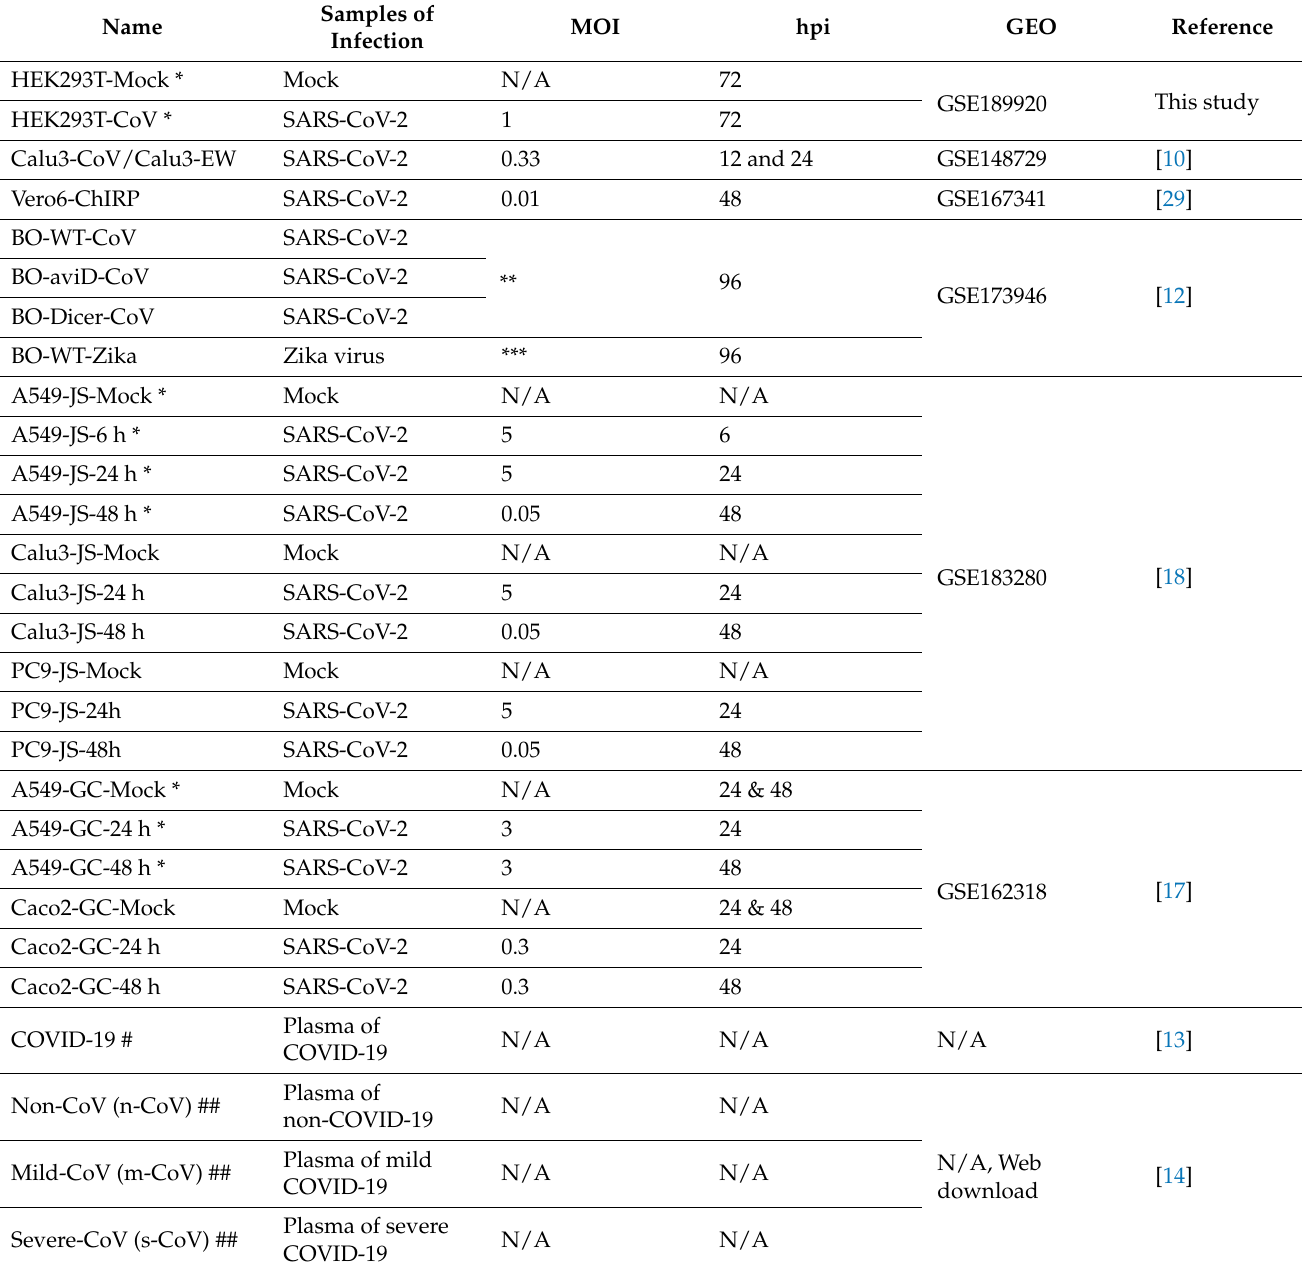
Table 1. smRNAseq and ChIRP datasets and their abbreviated names used in the study (in both main text and